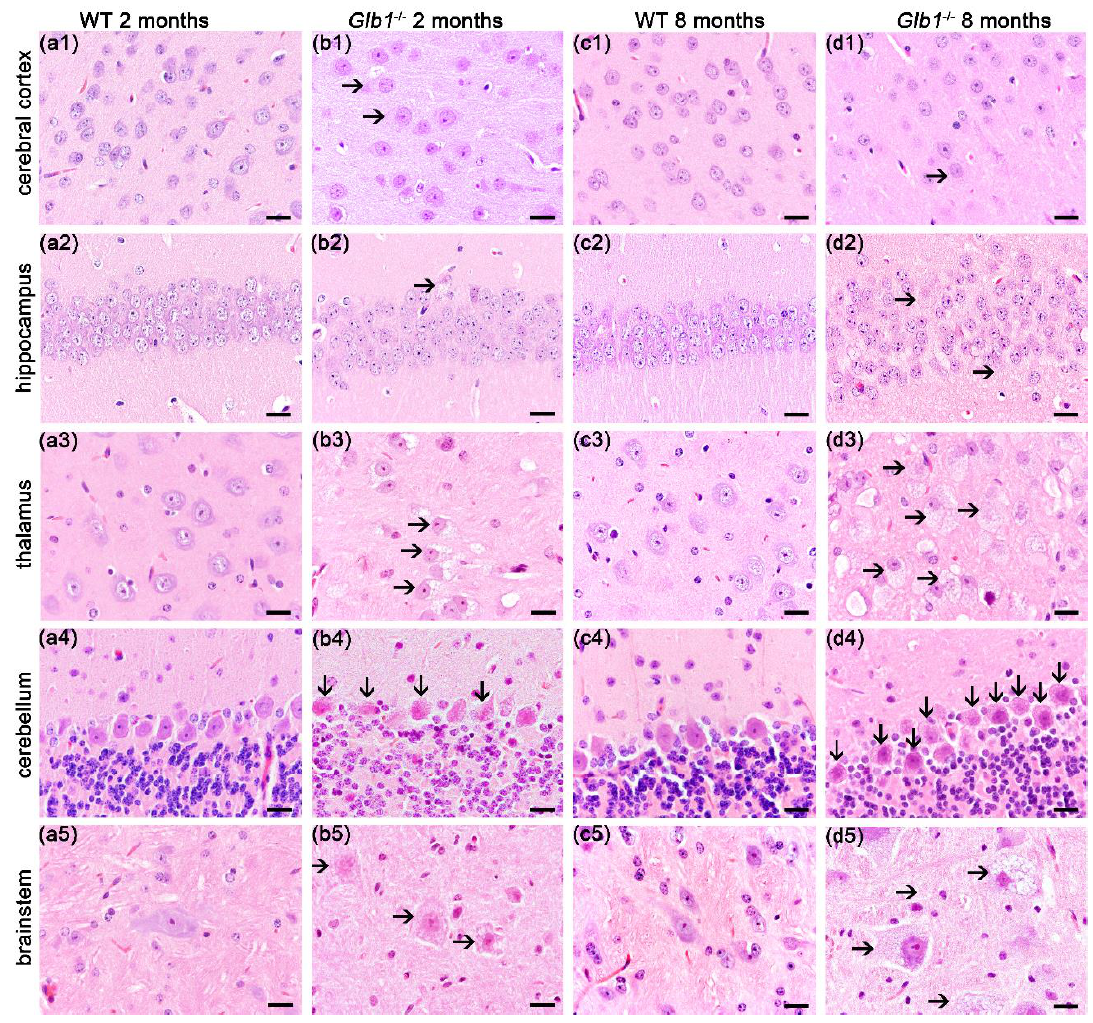
Figure 2. Histology of the brain in all examined areas in two- and eight-month-old mice. ( a1 – a5 , c1 – c5 ): Neurons of wildtype (WT) mice; ( b1 – b5 , d1 – d5 ): Neurons of Glb1 − / − mice with vacuolated neurons in all areas of the brain. Bars: 20 µm.